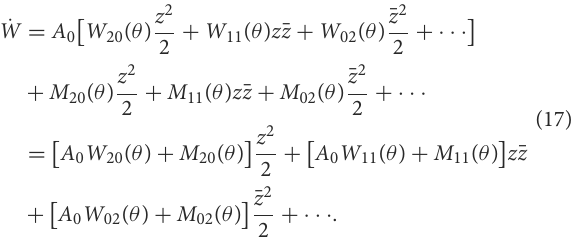
1, b 1, c 2, d 1, I 0.7, D u = = = = =